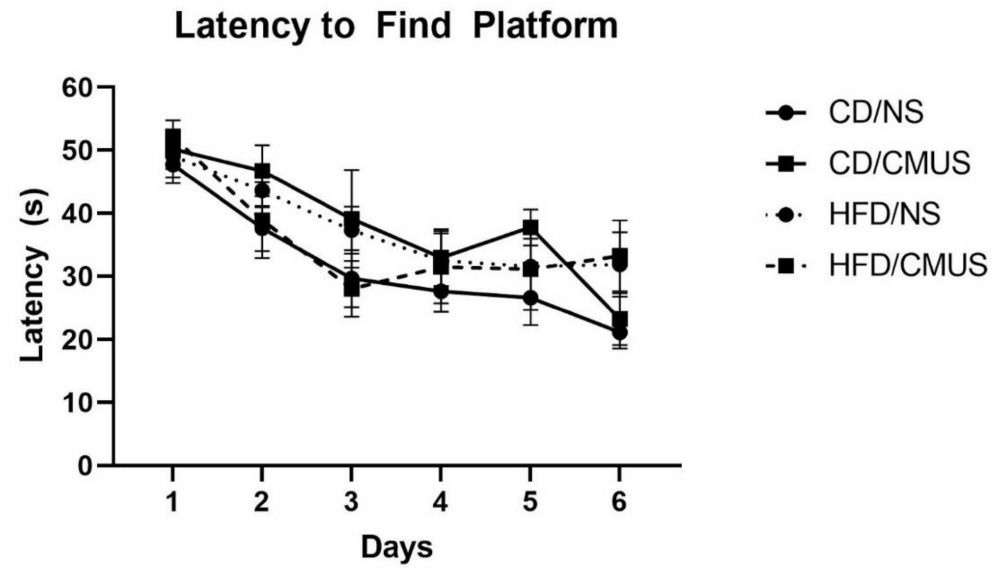
Figure 7. Latency to find the platform. Mice were able to learn to locate the hidden platform in the Morris Water Maze (MWM) task over time ( p < 0.001).